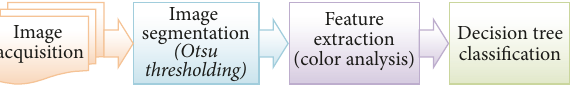
Figure 2: Research diagram